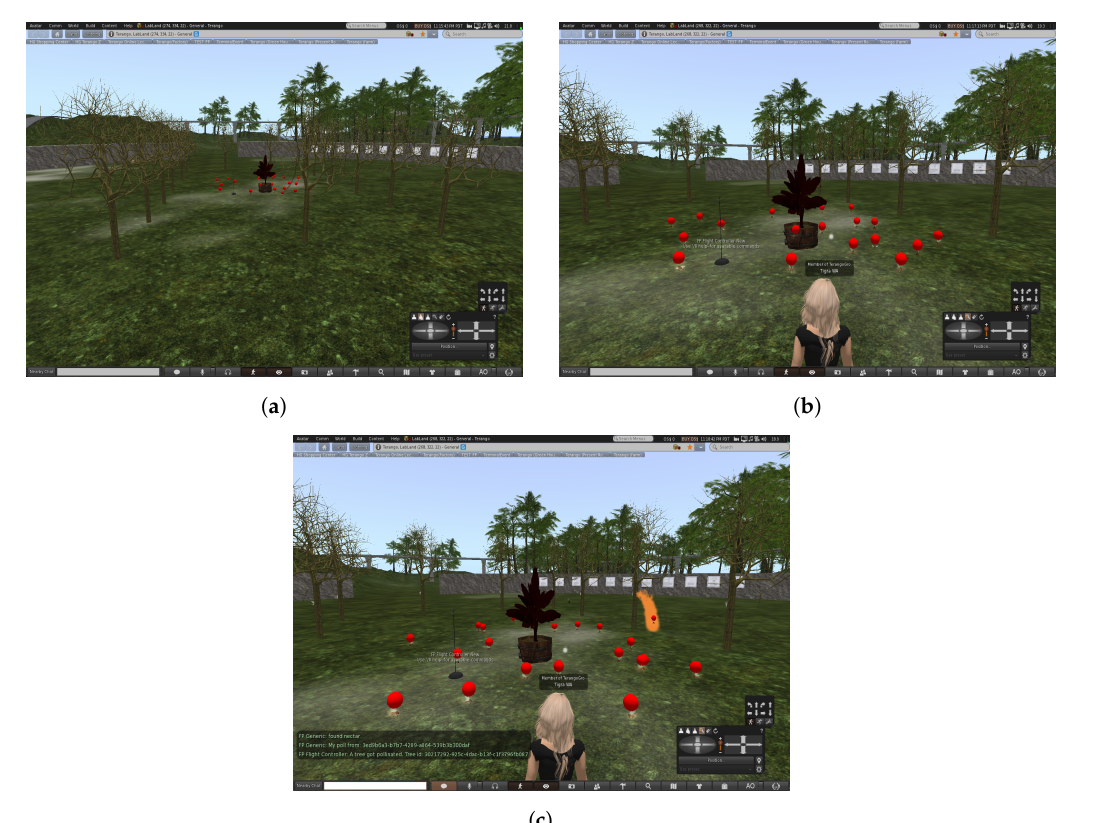
Figure 4. Implemented simulation in a 3D virtual environment. ( a ) FP randomly gathering around the breeding site. ( b ) FP starts searching trees. ( c ) A tree becomes